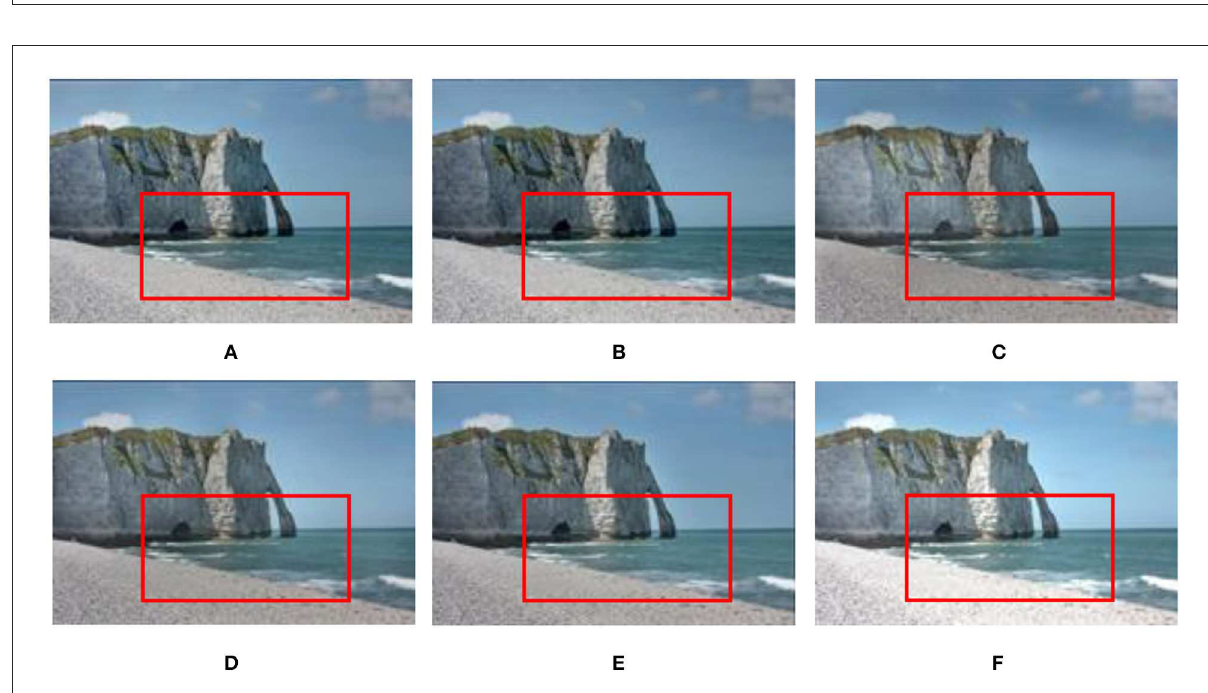
For underexposure source images, in the underexposure image, which retains the details of (cid:12) (cid:12) Equation (12) is introduced at the n -th level to correct the the underexposure areas. For overexposure images, the incorrect weights introduced by the weighted mapping weight map of the n -th level adopts the primary Gaussian smoothed by the Gaussian smoothing filter. It also smoothing filter to smooth, which retains the details of the reasonably enhances the weight of the well-exposure areas overexposure